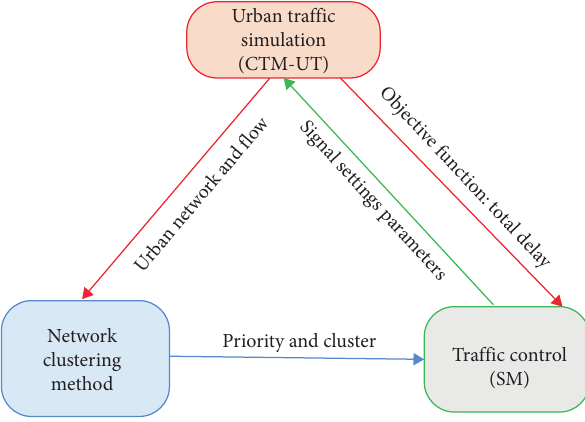
Figure 1: Scheme of our